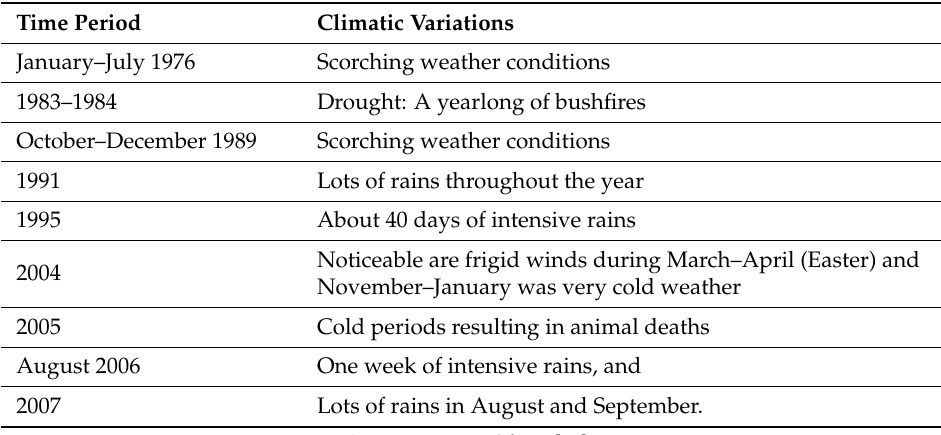
Figure 2. Location Map of Ghana. Table 3. Climatic variations experienced in